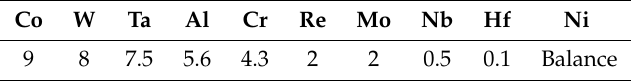
Table 1. Nominal chemical compositions of DD6 alloy (in wt. %).